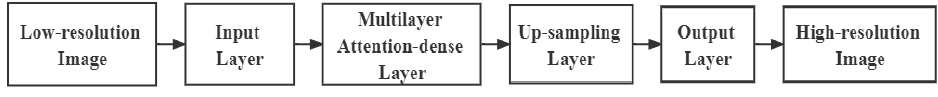
Figure 8. Algorithm flow chart.